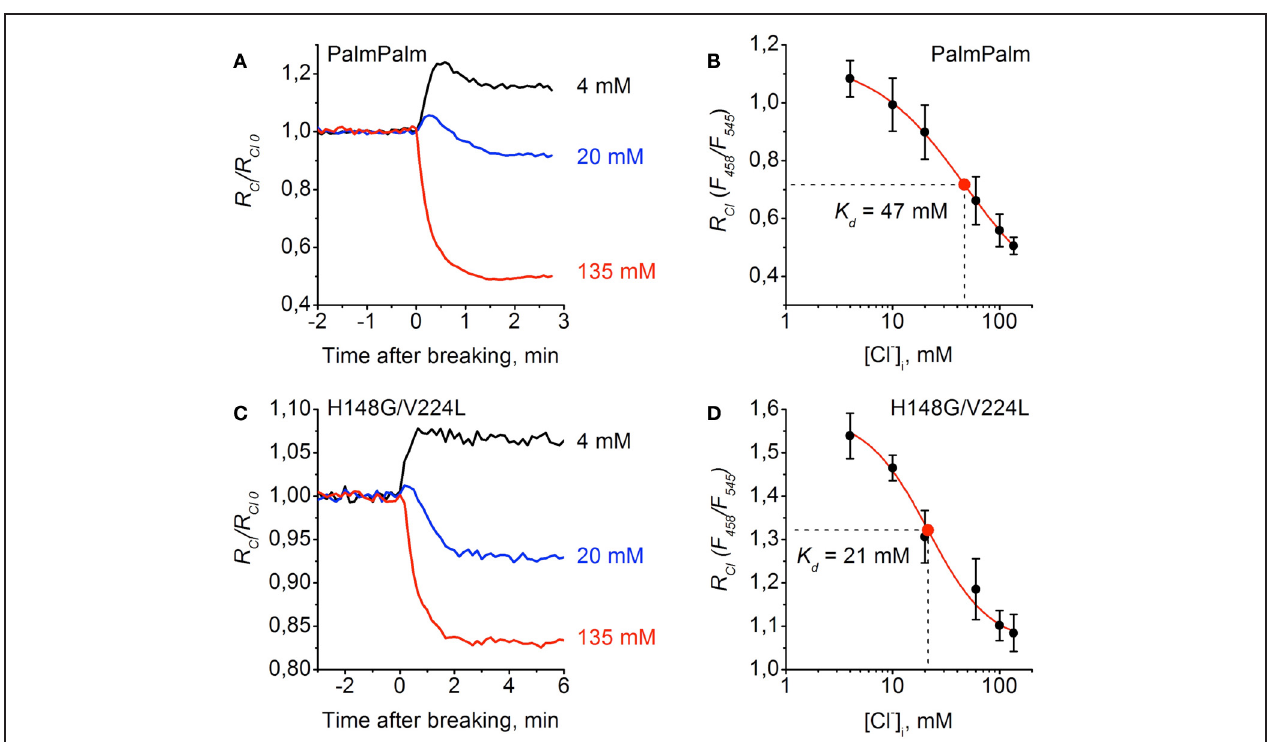
PalmPalm-ClopHensor (B) and H148G/V224L mutant (D) obtained by recording R Cl at six different [Cl − ] p : 4, 10, 20, 60, 100, and 135mM. For PalmPalm-ClopHensor K d = 46 . 8 ± 3 . 8mM and for H148G/V224L mutant K [Cl − ] i changed from 4 to 135mM and the much smaller dynamic range of R Cl for H148G/V224L mutant.